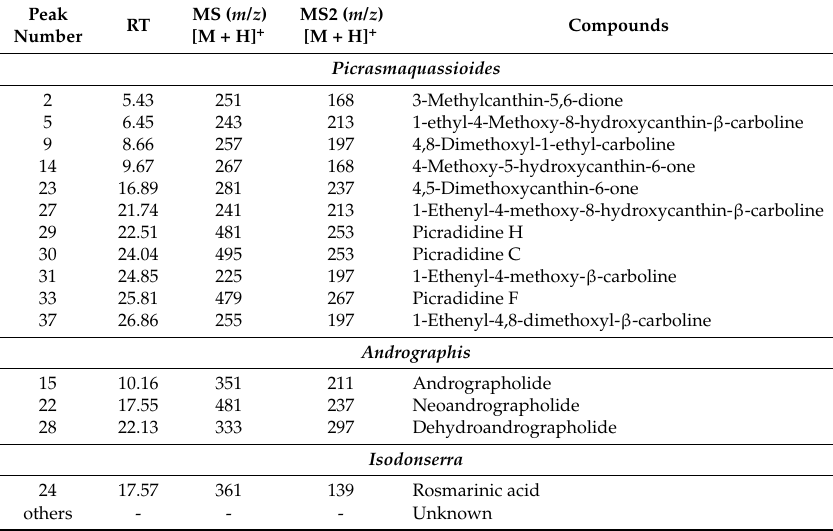
Table 1. Characterization of 15 compounds identified from